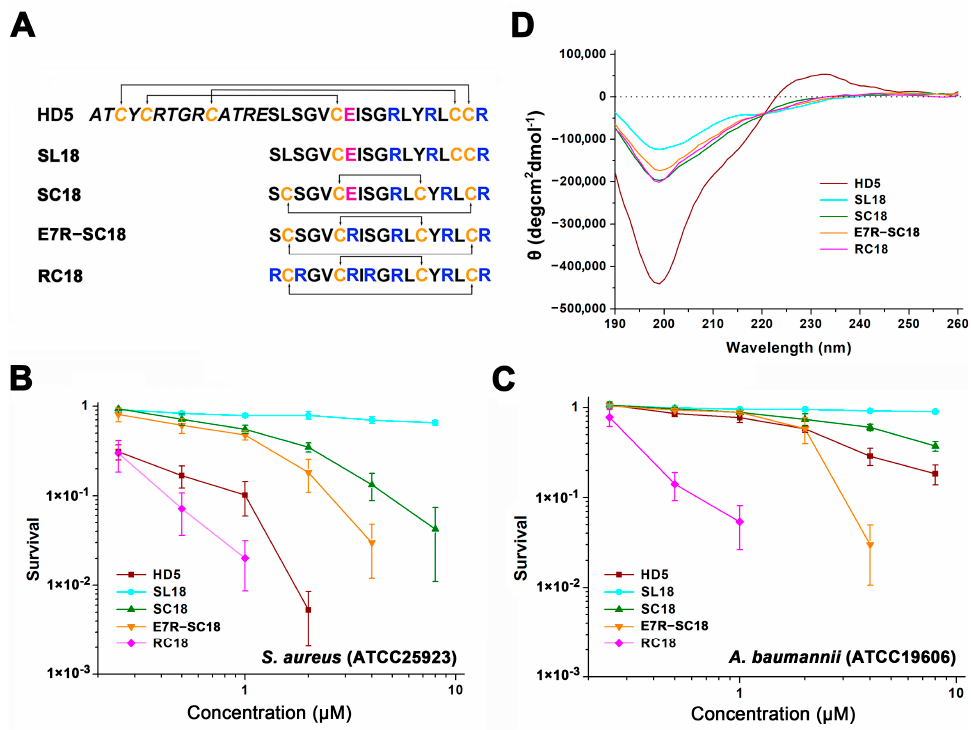
Figure 1. ( A ) Amino acid composition of the peptides. Cysteines are coloured orange. Glu21 is coloured pink. Arginines in the γ -core motif are coloured blue. ( B ) Virtual colony count assays were used to determine the antibacterial action of the peptides against S. aureus (ATCC 25923) and ( C ) A. baumannii (ATCC 19606). Bacterial survival was calculated as the ratio of the number of surviving colonies after treatment with peptides (0.25, 0.5, 1, 2, 4, and 8 μ M) to the total number of colonies in the control group. Spots below 10 − 3 bacteria were considered totally inactive and are not shown. The results are presented as the mean ± standard deviation (SD). ( D ) CD spectra of the peptides in water.